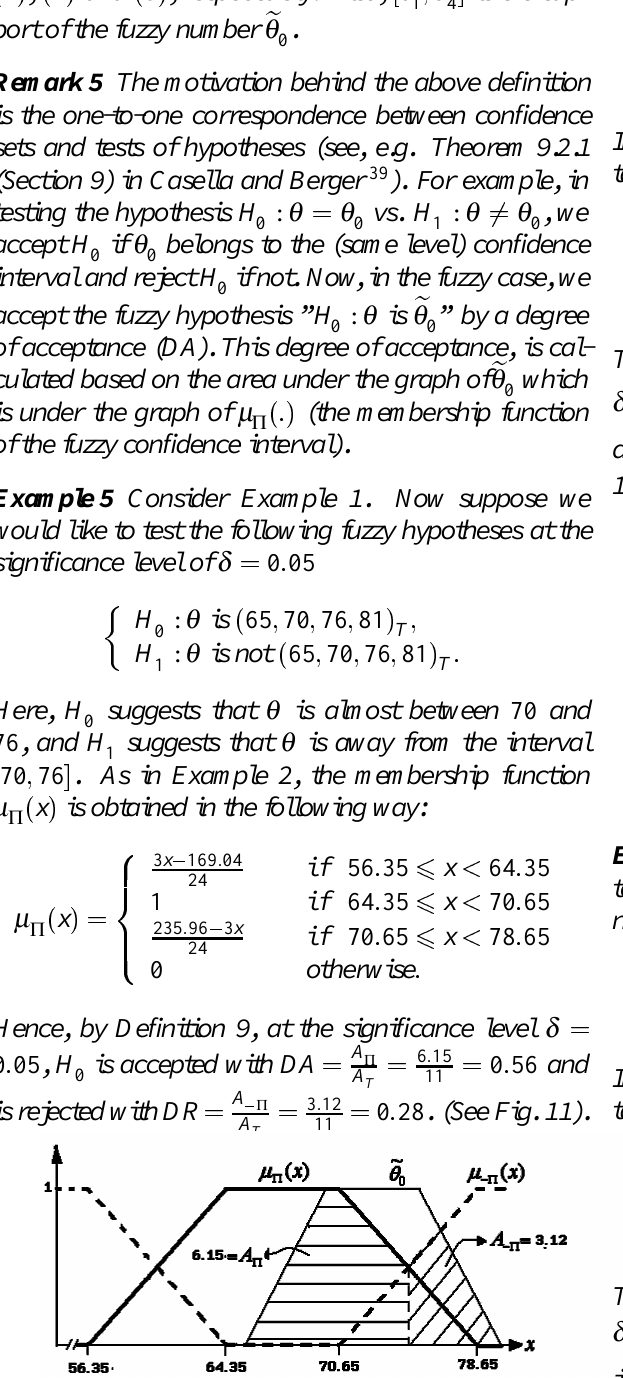
0 56 ( DR (cid:2) (cid:0)